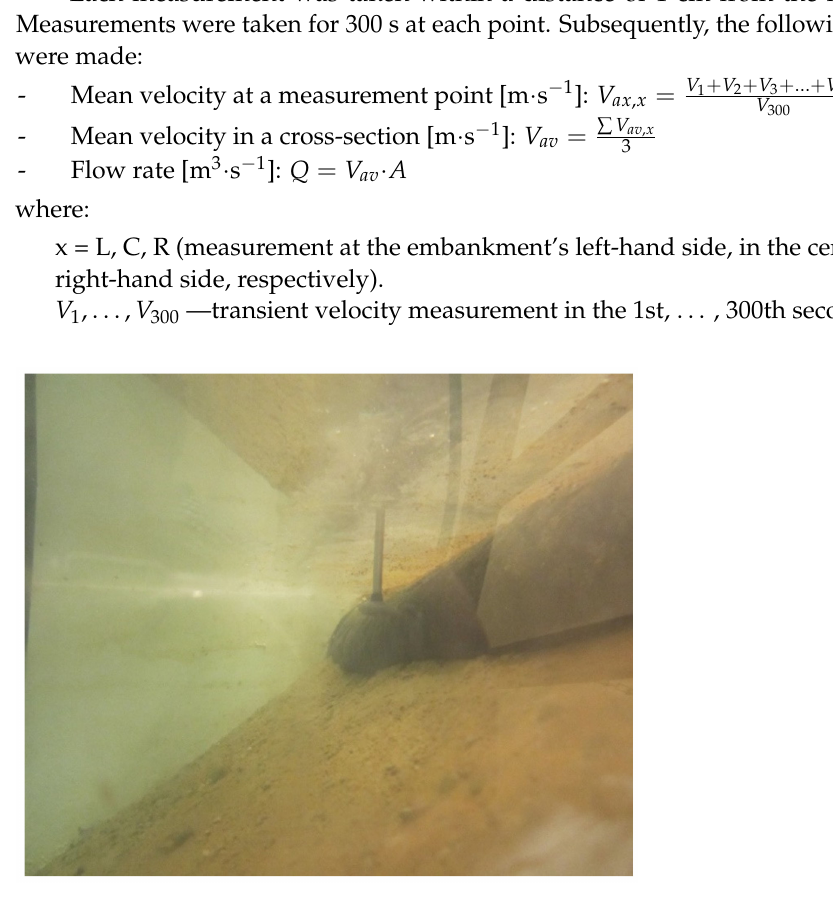
Figure 6. Sample flow velocity measurement at a location where water is sucked in by gravel drainage. The inlet to the drainage is protected by a geotextile against the suction of fine soil particles leading to clogging of the drainage